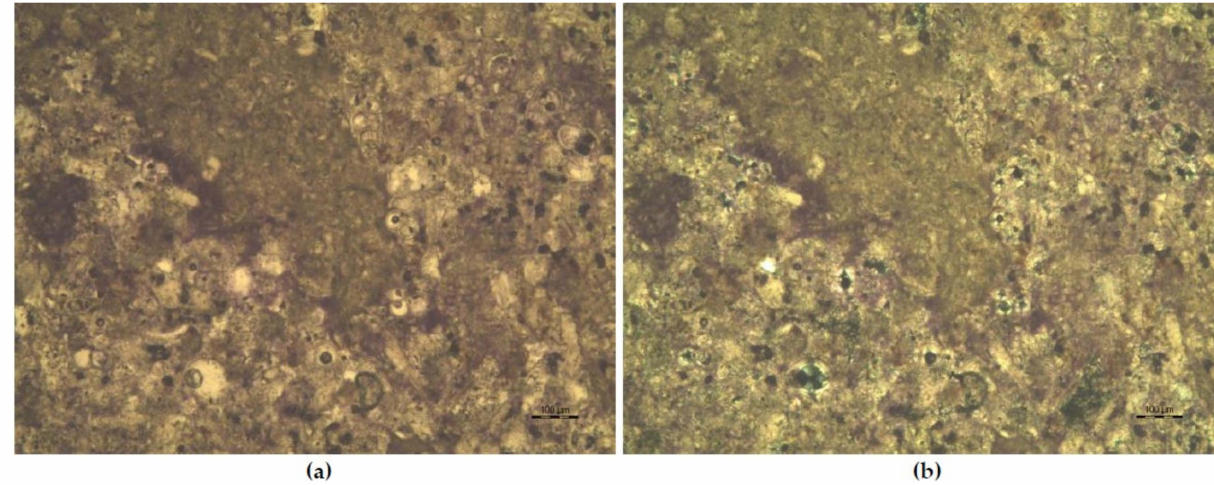
Figure 10. Sample C1: ( a ) plane-polarized light: micrite is recrystallized to microspar and containing planktonic Globigerina and benthic foraminifera, in the central part the micrite is preserved and looks like as micrite intraclast; ( b ) cross-polarized light: same view as ( a ), intraparticle porosity.